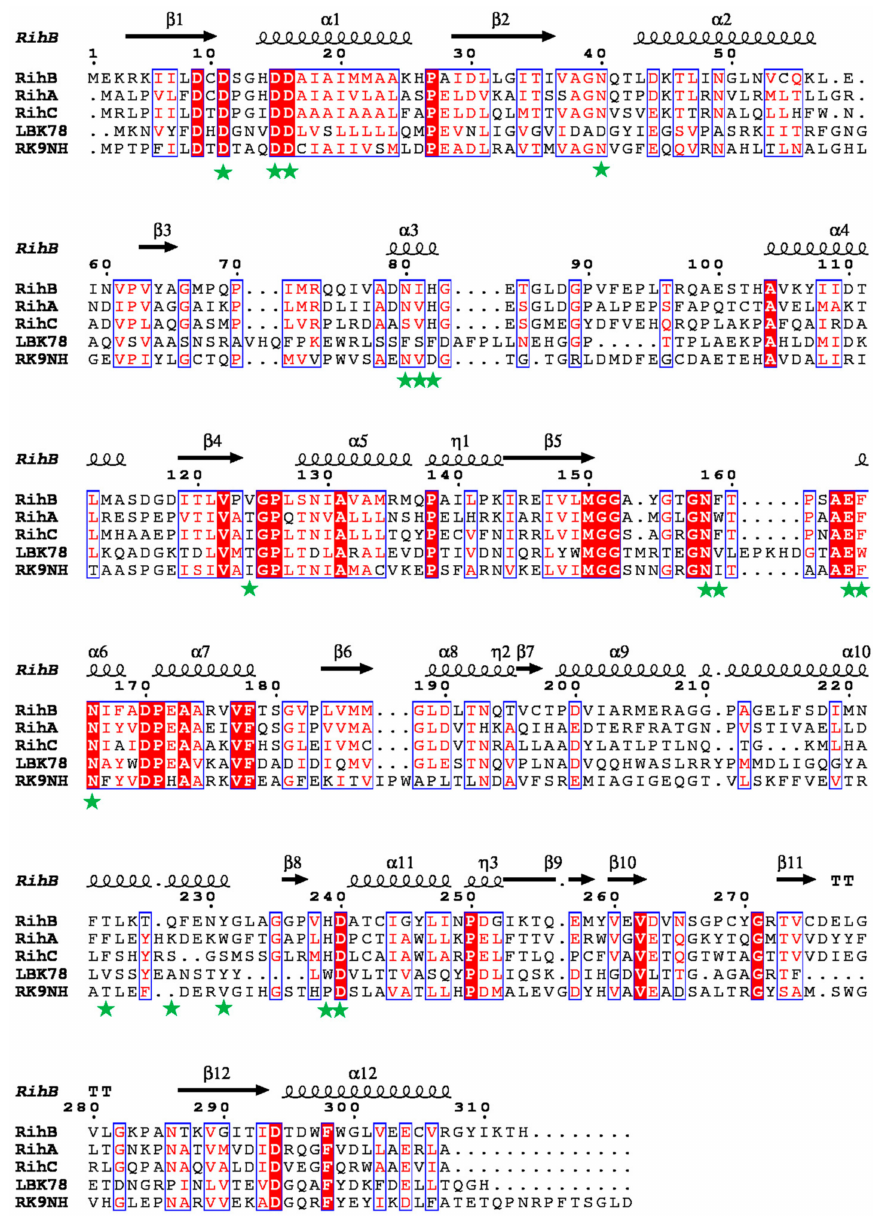
Figure 3. Multiple amino acid sequence alignment of nucleoside hydrolases. RihB: pyrimidine-specific ribonucleoside hydrolase from E. coli [39]; RihA: pyrimidine-specific ribonucleoside hydrolase from E. coli [33]; RihC: non-specific ribonucleoside hydrolase from E. coli [33]; LBK78: 2 (cid:48) - O -methylribonucleoside-specific nucleoside hydrolase from Lactobacillus buchneri LBK78 [27]; RK9NH: nucleoside hydrolase discovered in the metagenomic libraries. Highly similar residues are in red and framed in blue, strictly identical residues are in white on a red background. Green stars indicate the amino acid residues that form the active site of RihB [39]. The alignment was performed using Clustal Omega [40] and ESPript